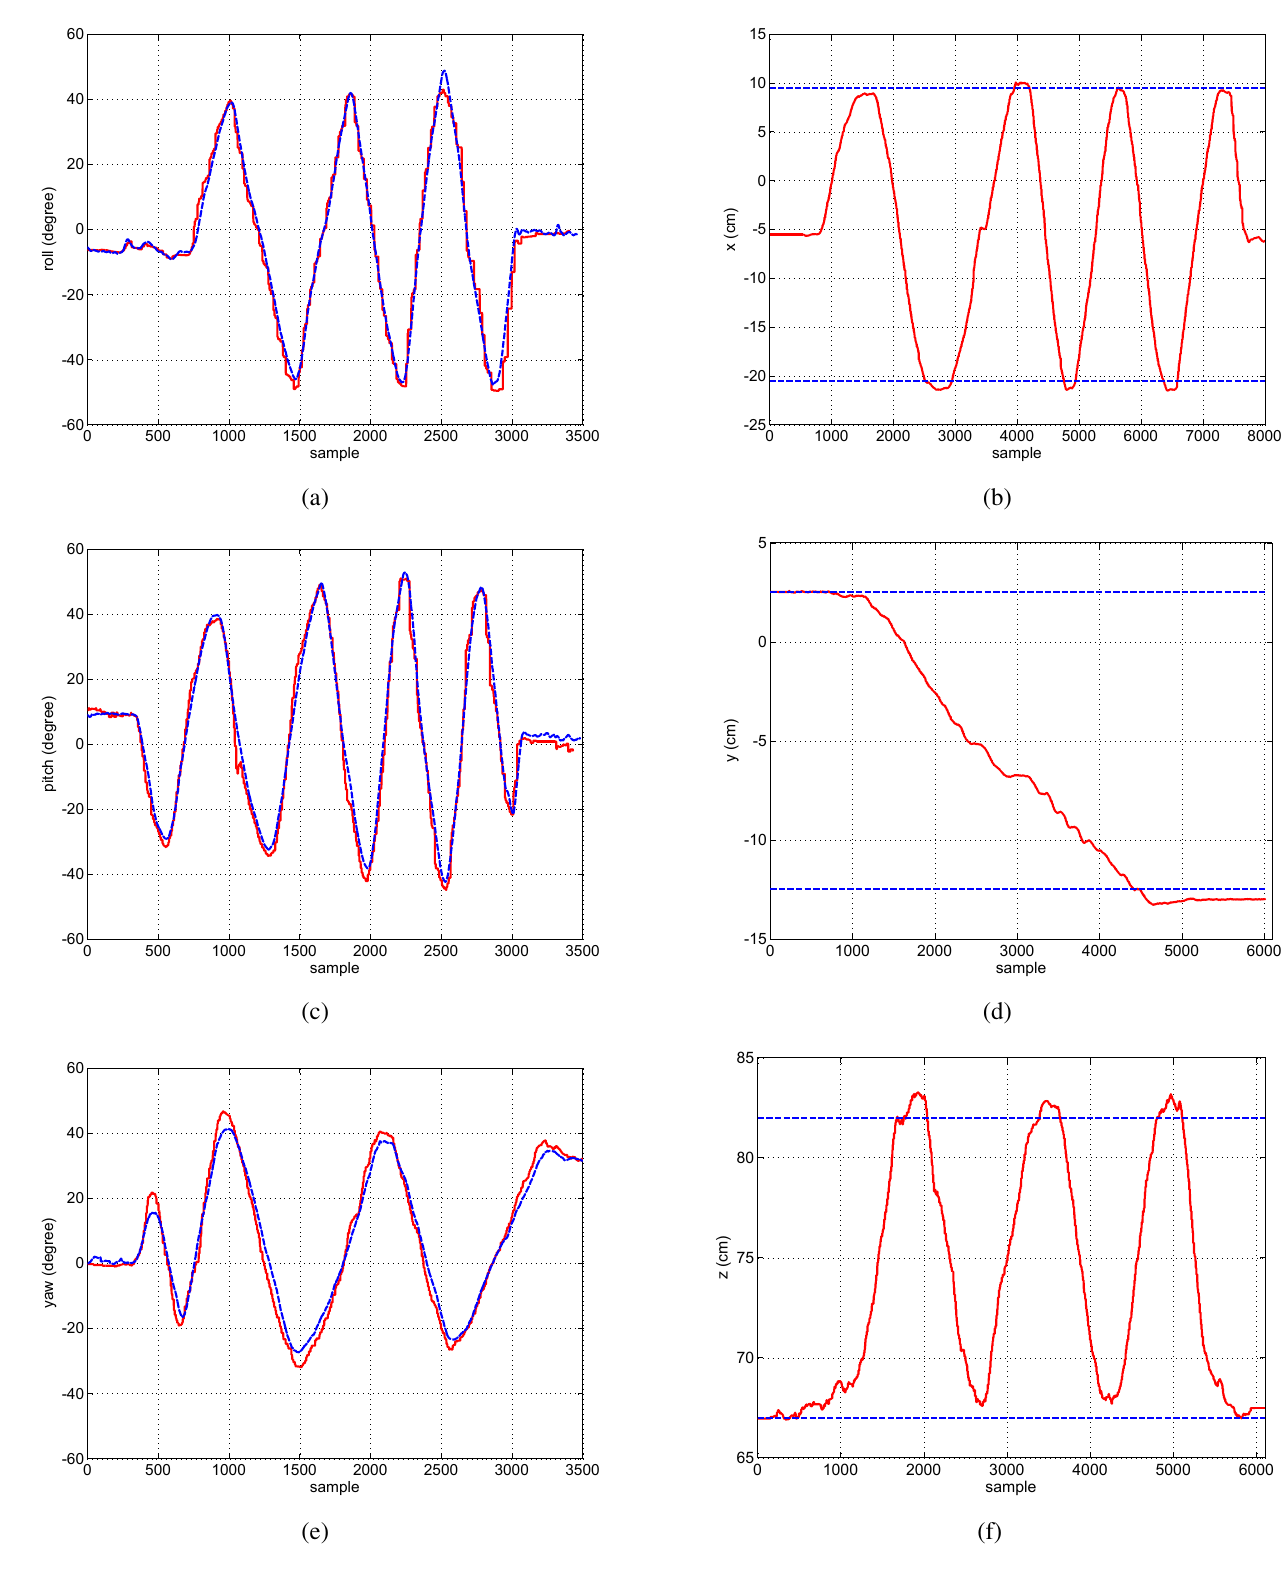
Figure 12. Left : Three different experiments with roll, pitch and yaw rotations. Dashed blue line: Ground-truth provided by the IMU. Red solid line: Head-tracking system estimation. Right : Three different experiments with displacements in ˆ x , ˆ y and ˆ z axes. Dashed blue line: Measured displacement. Red solid line: Head-tracking system